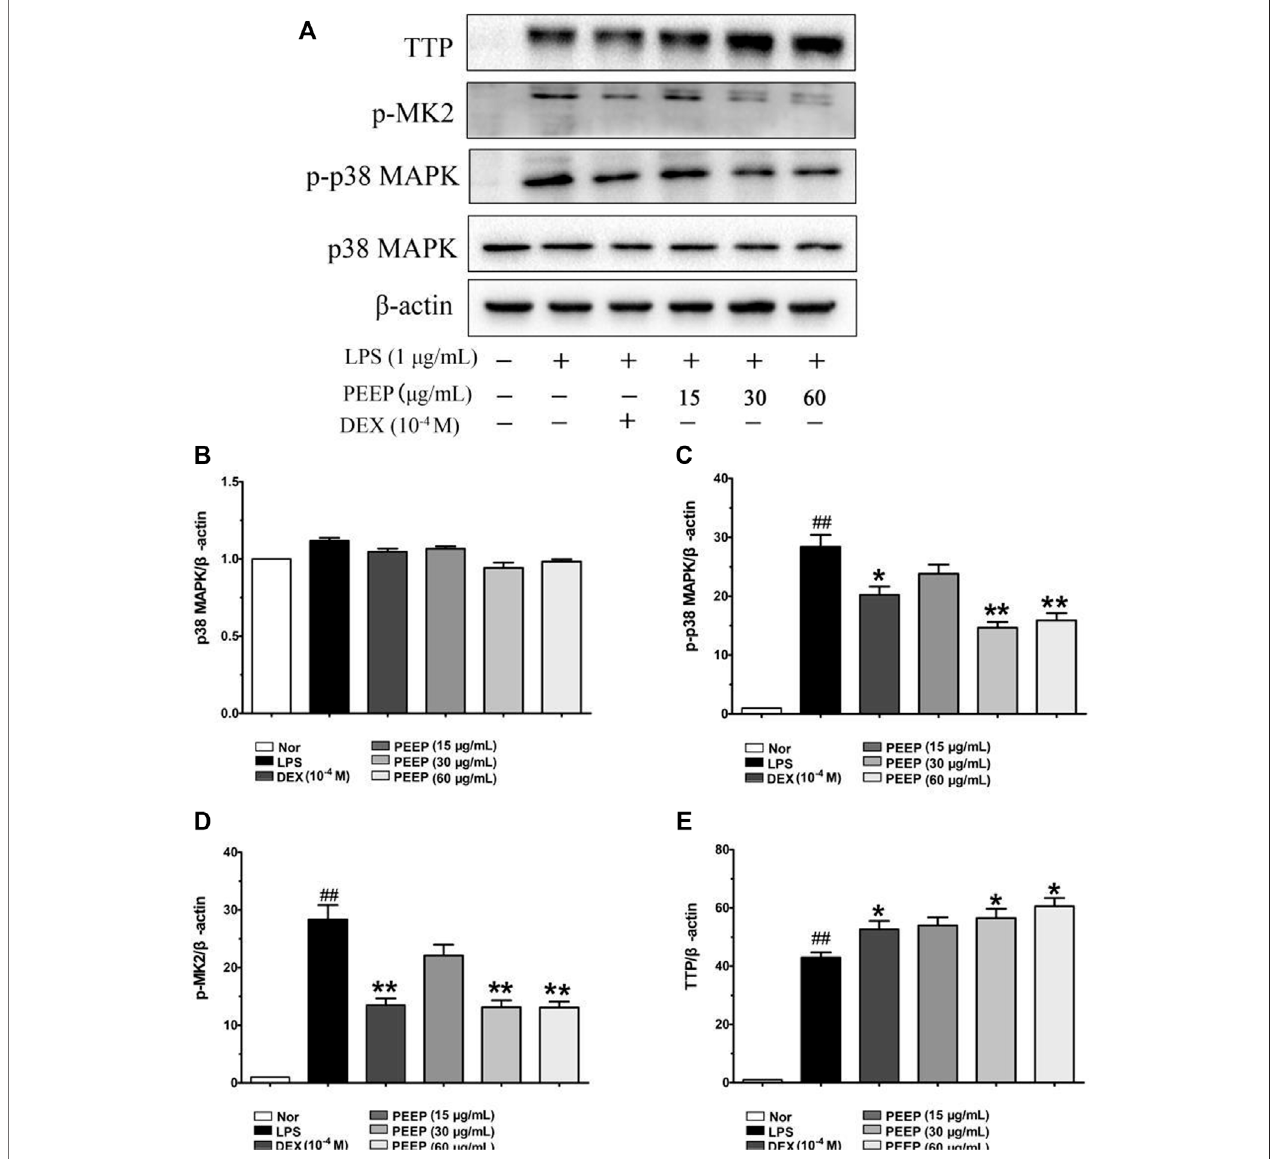
FIGURE 4 | Effectof PEEP on p38, p-p38, p-MK2, and TTP expressions induced by LPS in RAW264.7 macrophages. (A) The protein expressions of p38, p-p38, p-MK2, and TTP were detected by using western blot analysis. (B) Quantitative analysis of gray value of p38 was performed in several groups with β -actin as loading control. (C) Quantitative analysis ofgray value ofp-p38was performed in several groups with β -actin asloading control. (D) Quantitative analysisof gray value of p-MK2 was performed in several groups with β -actin as loading control. (E) Quantitative analysis of gray value of TTP was performed in several groups 27 with β -actin as loading control. Data represent the mean ± S.E.M. of three independent experiments. ## p < 0.01 vs. Normal group; * p < 0.05, ** p < 0.01. vs. LPS